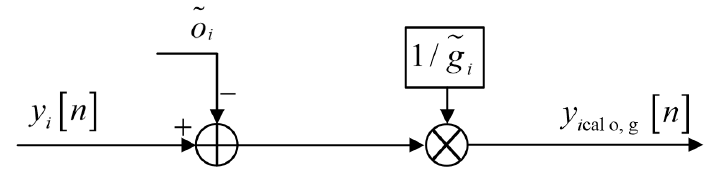
Figure 2. Proposed structure of correction offset and gain.